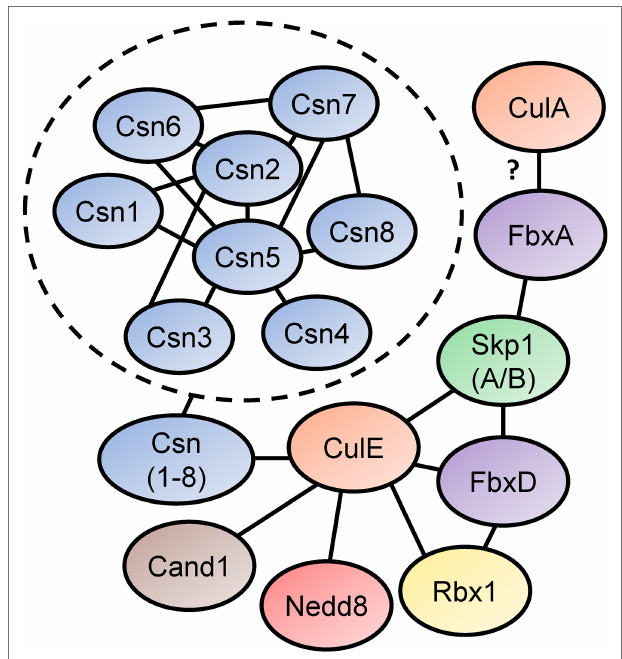
FIGURE 5 | Skp1-Cullin-F-box (SCF) complex interactome reveals components of the neddylation pathway and subunits of the CSN. Sheikh et al. (2015) identified proteins that interact with D. discoideum Skp1, FbxD, and CulE after performing co-immunoprecipitations for each protein. Interactors were identified using LC–MS/MS. Connecting lines indicate the interactions between the proteins. Mohanty et al. (2001) reported an interaction between a Dictyostelium discoideum cullin (presumably CulA) and FbxA. In the dashed circle, CSN subunit interactions with one another are shown. This was determined in a yeast two-hybrid screen by Rosel and Kimmel (2006). Cand1, cullin-associated Nedd8-dissociated protein 1; Csn, COP9 signalosome; Cul, cullin; Fbx, F-box protein; Nedd8, neural precursor cell expressed developmentally downregulated protein 8; Rbx1, ring box 1/ regulator of cullins 1; and Skp1, S phase kinase-associated protein